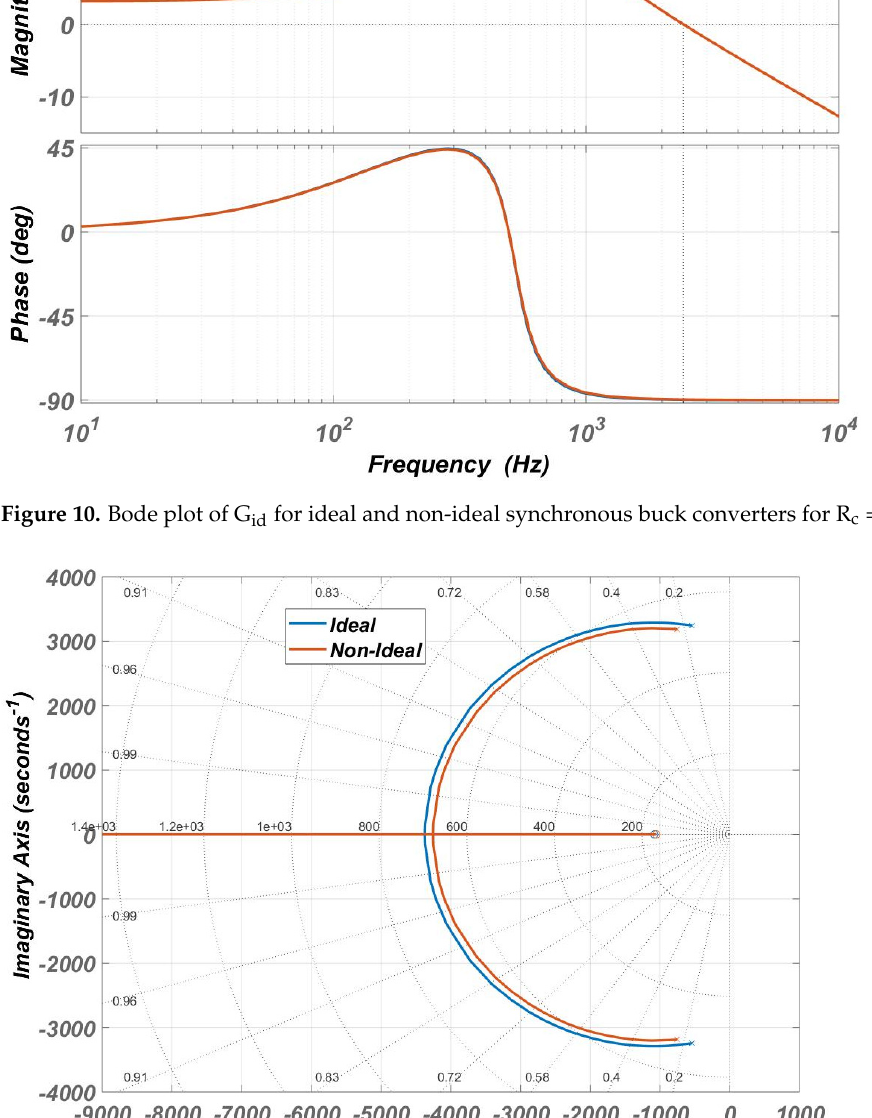
Figure 11. Root locus of G id for ideal and non-ideal synchronous buck converters. The bode plot of the G id is analyzed for non-ideal buck and synchronous buck con- verters and is shown in Figure 12. The phase margins for the converters were 91.9° and 92°, respectively. It is observed from the frequency response of the converters that there is no change in the characteristics of the G id . Hence, the placement of poles and zeros also remains the same. This is evident from Figure 13.